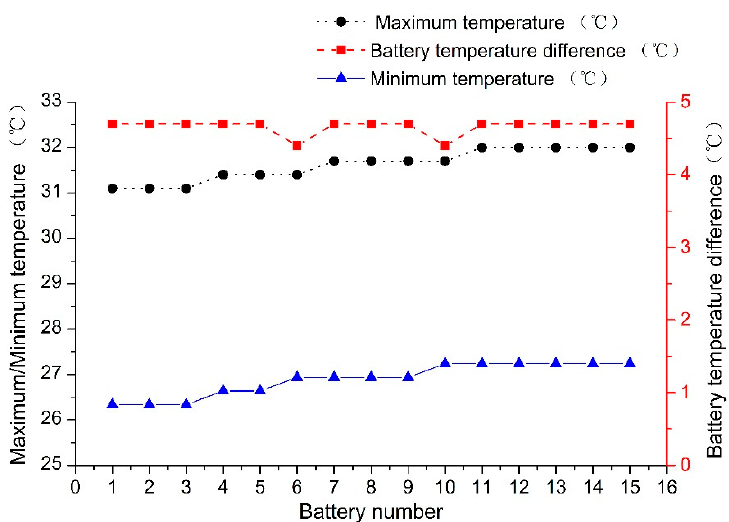
Figure 15. Battery Figure 15. Battery temperature.